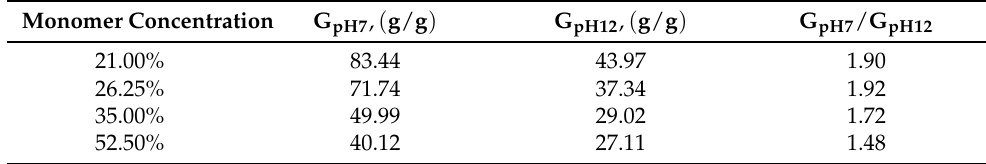
Table 5. The saturated absorption rates of SAPs prepared with different monomer concentrations tested at 90 ◦ C in water (pH = 7) and in NaOH solution (pH = 12), and the pH-sensitive index. Monomer Concentration G pH7 , ( g / g ) G pH12 , ( g / g )